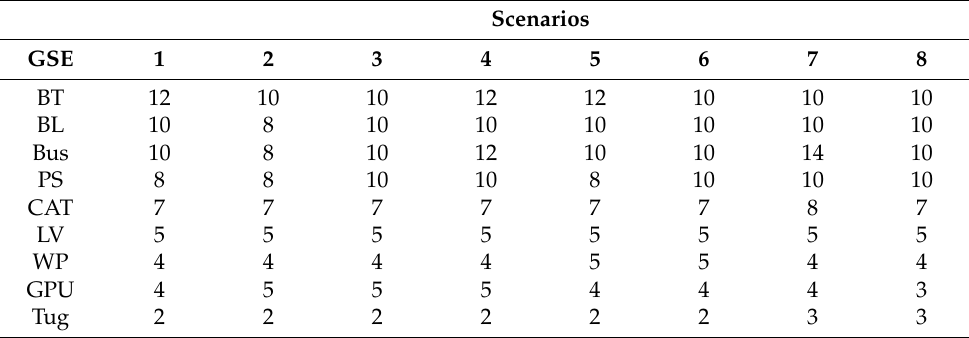
Table 6. Number of vehicles required per GSE group according to modelled